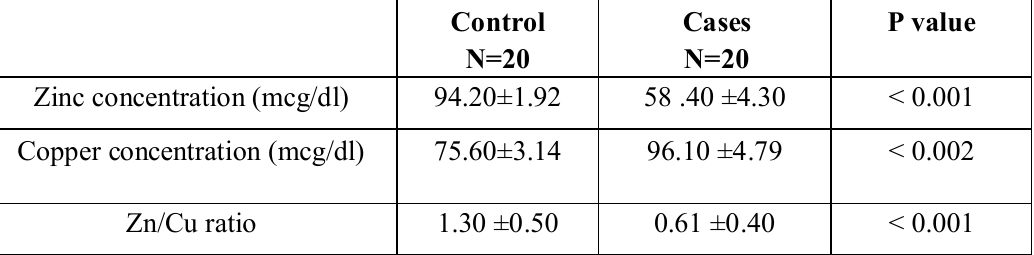
Table 1: Case- control differences in mean of certain outcome variables .